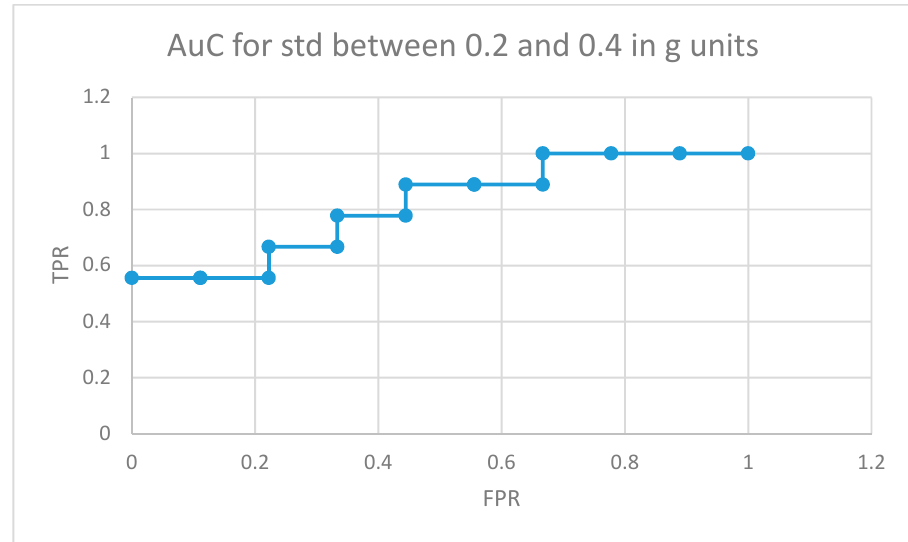
Figure 10. AuC for medicated participants with ADHD for movement fragments with the combined standard deviation between 0.2 and 0.4 in g units.